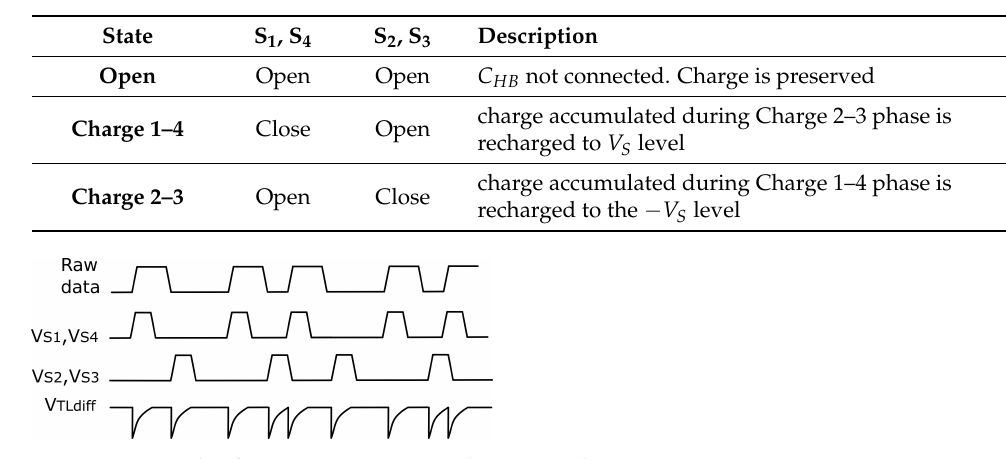
Table 1. States of H-Bridge transmitter topology.